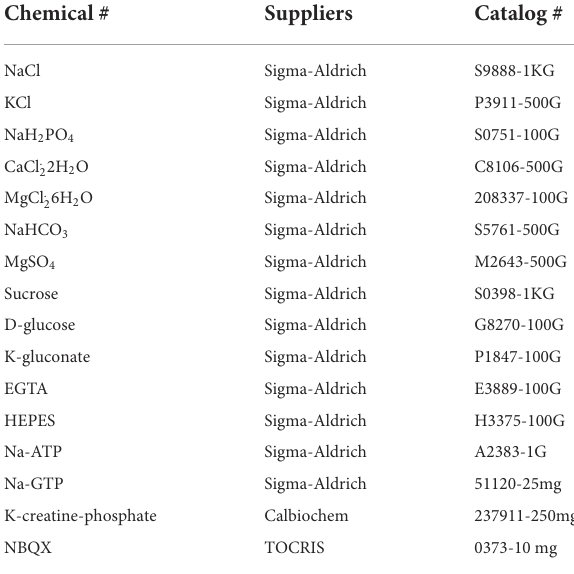
TABLE 1 Chemical list for this method